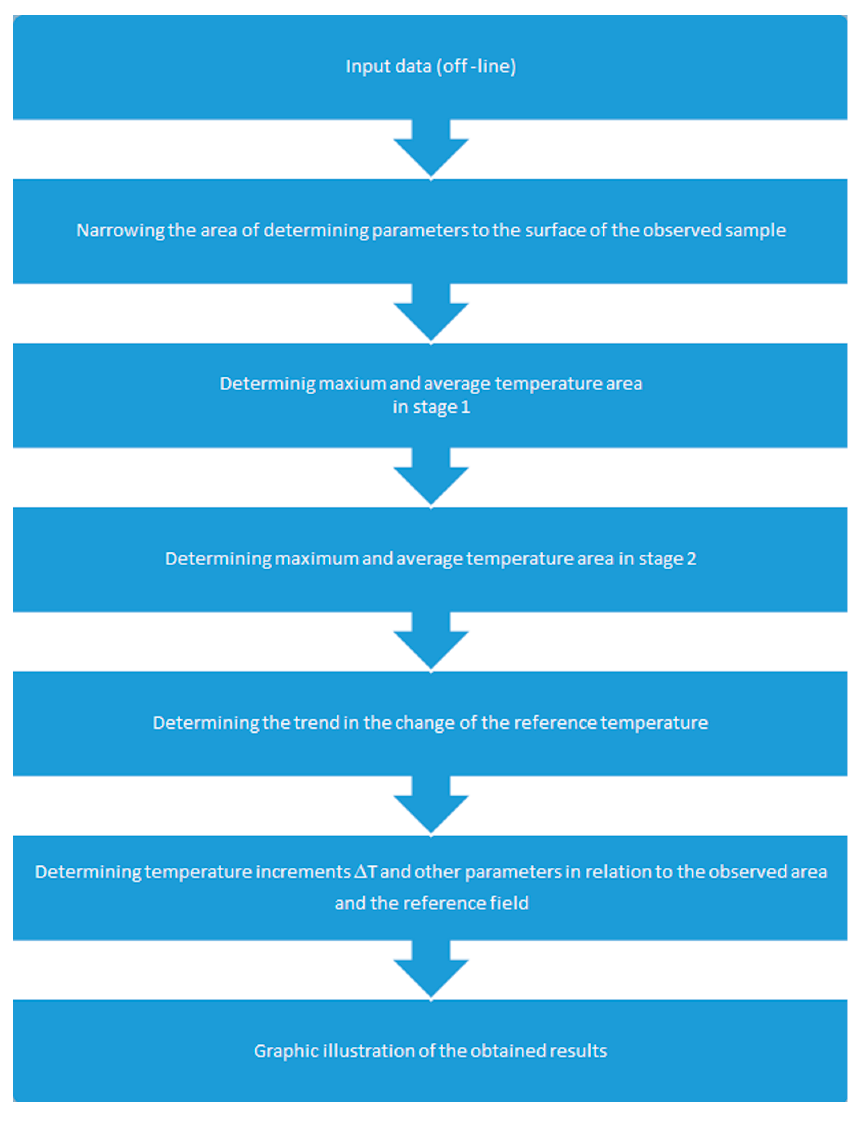
Figure 4. Graph of the algorithm used to determine thermal parameters.